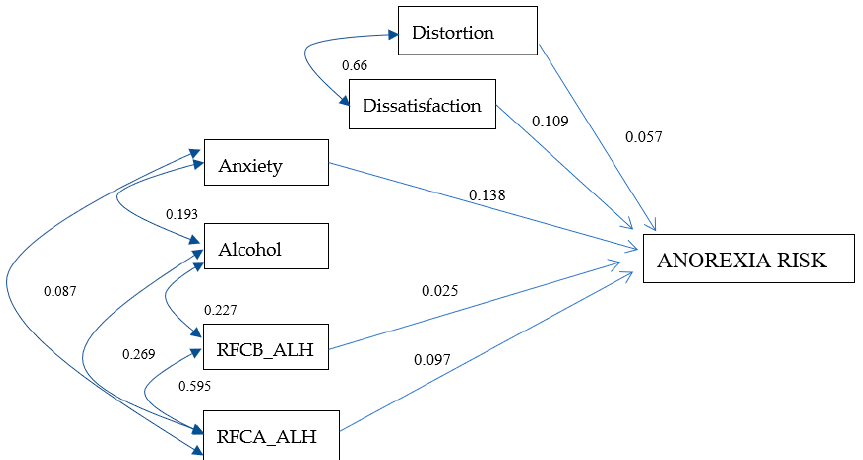
Figure 1. Male anorexia risk model. The values on one-headed arrows are the standardized regression weights and those on each two-headed arrow are the correlations for the model. The shapes in the diagram are defined as follows: small ovals are measurement or prediction errors; rectangles, measured variables. RFCB_ALH: food restriction before consuming alcohol. RFCA_ALH: food restriction after consuming alcohol. X 2 = 13.067, p = 0.192, CFI = 0.989, PNFI = 0.457, RMSEA = 0.037, and R 2 = 0.058.